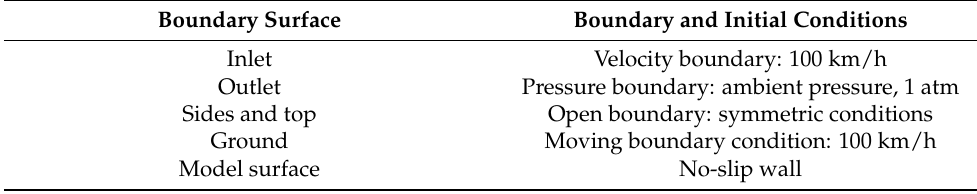
Table 1. Boundary and initial conditions on the control volume.